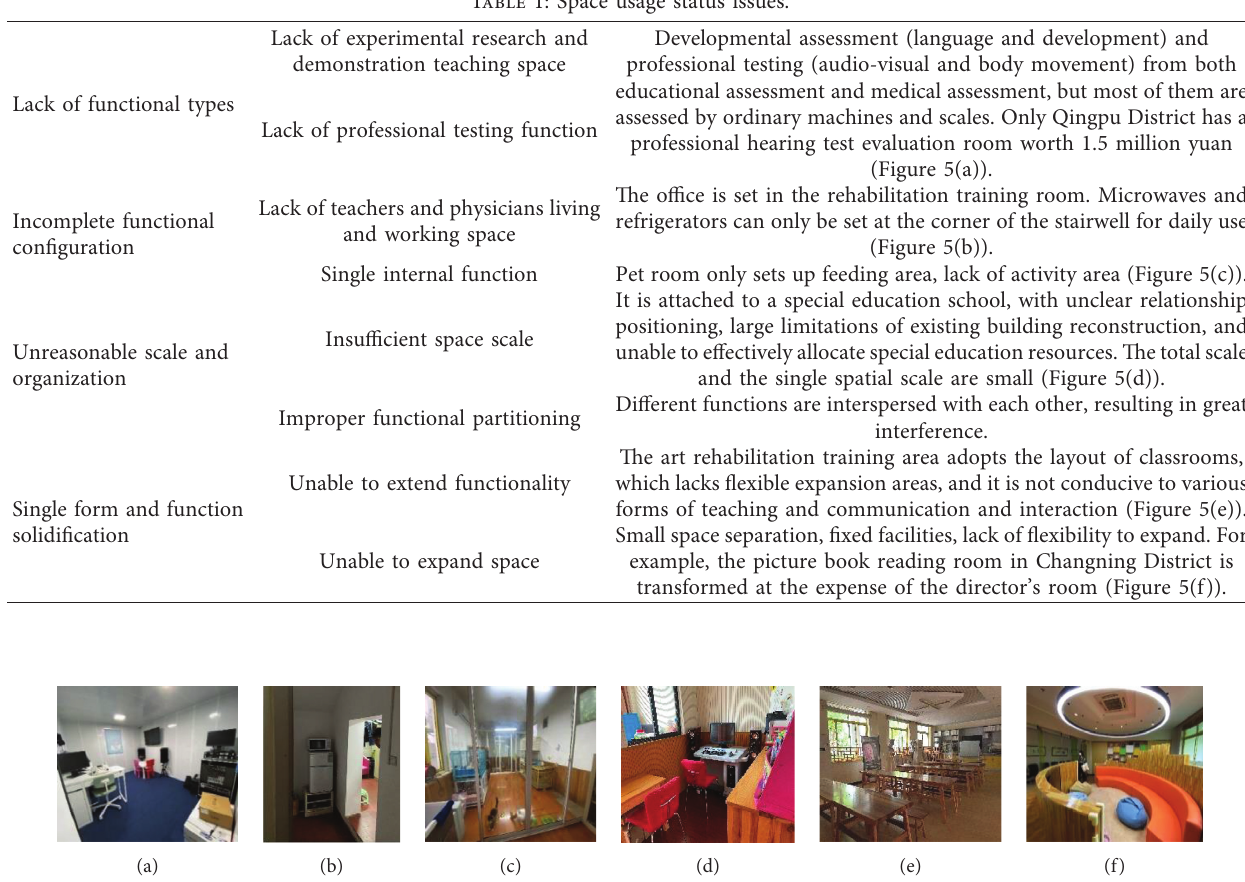
Figure 5: (a) Hearing testing room. (b) Domestic installation. (c) Pet room. (d) Psychotherapy indoor office. (e) Art district classroom. (f) Picture book reading room.